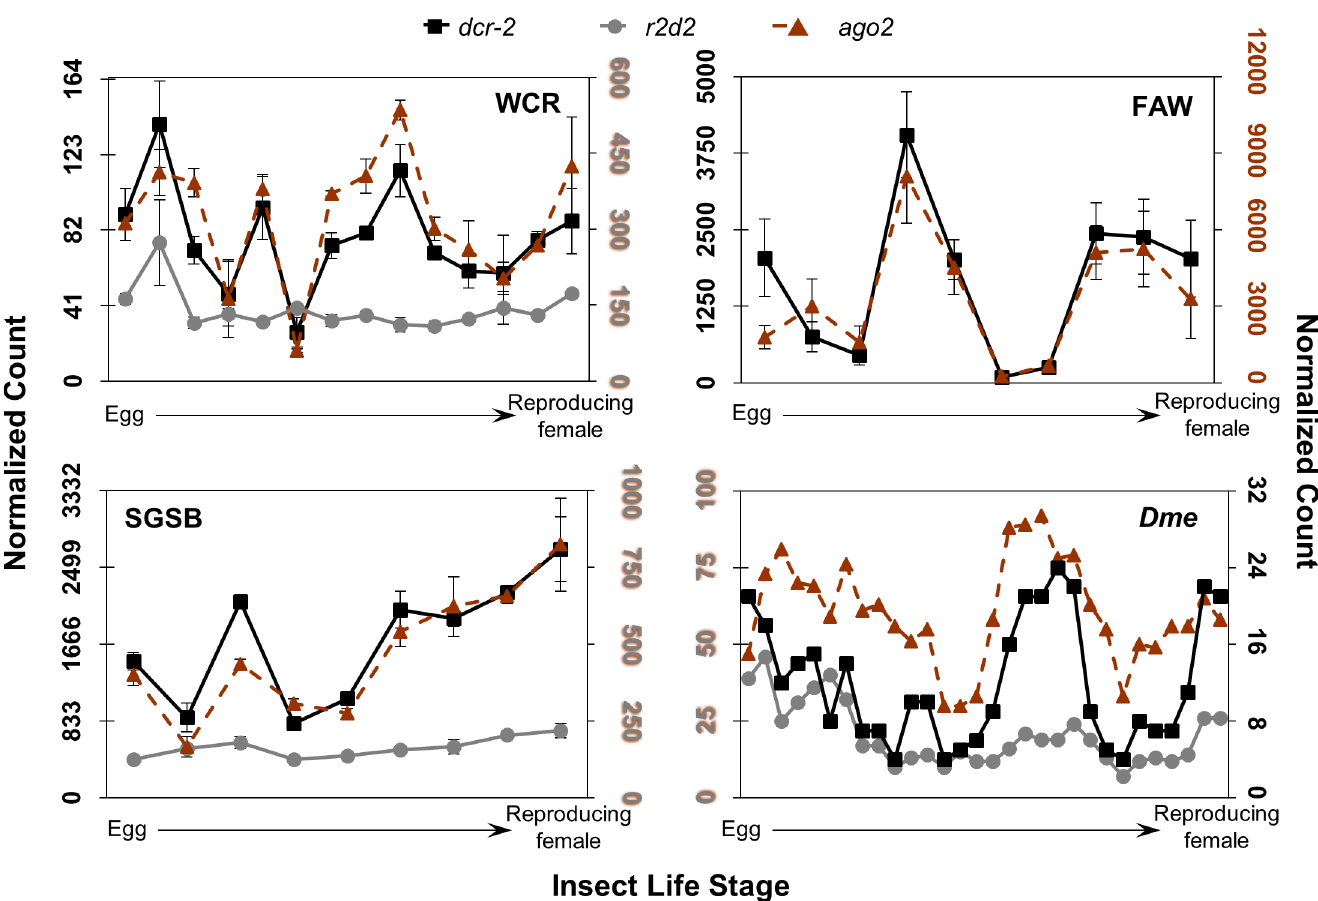
Fig 6. Expression patterns of core siRNA machinery across insect life stages. Normalized count data for each insect are plotted and resulting plots are positioned as in Fig 4. dcr-2 is shown in black squares, r2d2 in grey circles, and ago2 in orange triangles with dotted line. The WCR graph scales r2d2 and ago2-RBa on the left axis, and dcr-2 on the right. The FAW graph scales ago2-REa on the left axis, and dcr-2 on the right. The SGSB graph scales dcr-2 on the left axis, and r2d2-RAa and ago2-RB on the right; axes colors also reflect gene target scaling. The Dme graph scales r2d2 and ago2 on the left axis, and dcr-2 on the right; specific isoforms are unknown.